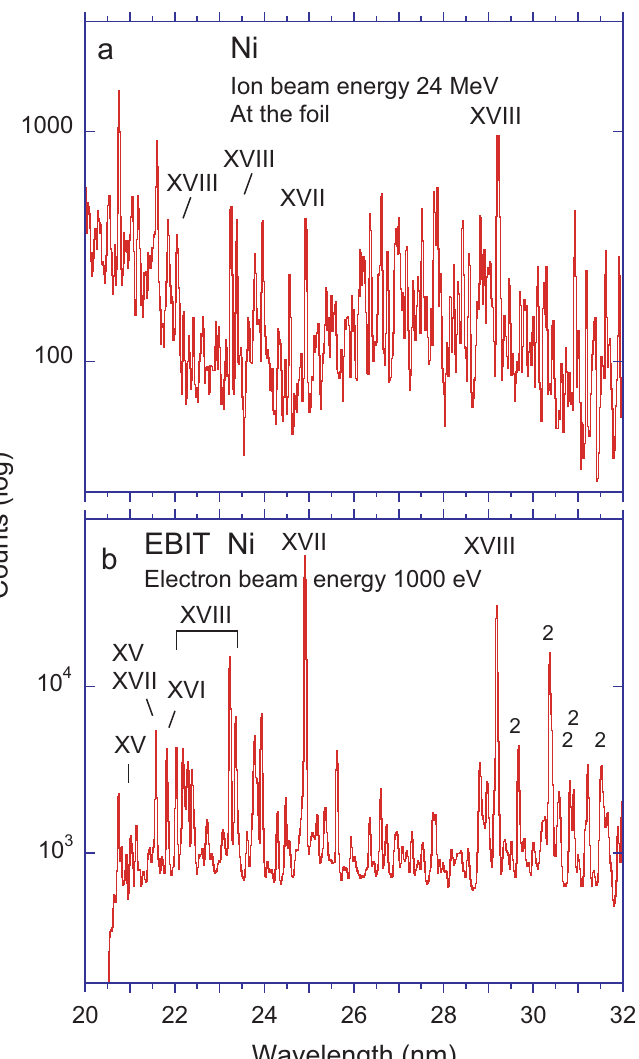
Figure 18. Spectra of Ni in two different light sources. ( a ) Beam–foil spectrum at an ion beam energy of 24 MeV. Line width (FWHM) 0.045 nm. Several of the strongest lines are identified by the spectrum number; ( b ) electron beam ion trap spectrum at an electron beam energy of 1 keV. The flat-field spectrograph setting is the same as used for the spectra in Figures 14 and 15. Line markers with an Arabic ‘2’ indicate second diffraction order